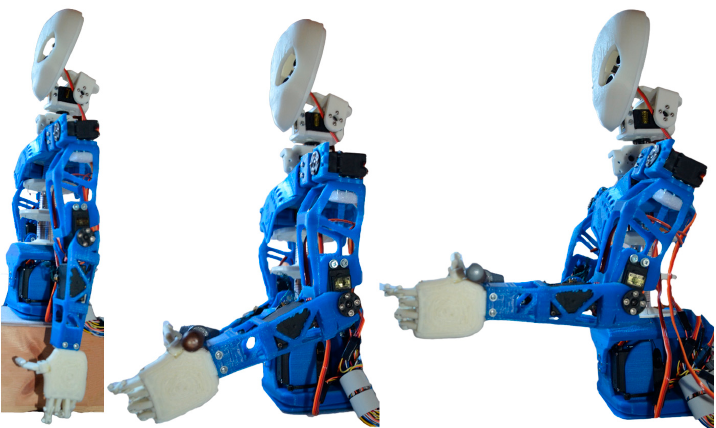
Figure 8. A snapshot of the torso lifting a payload of 0.560 kg using the arms.